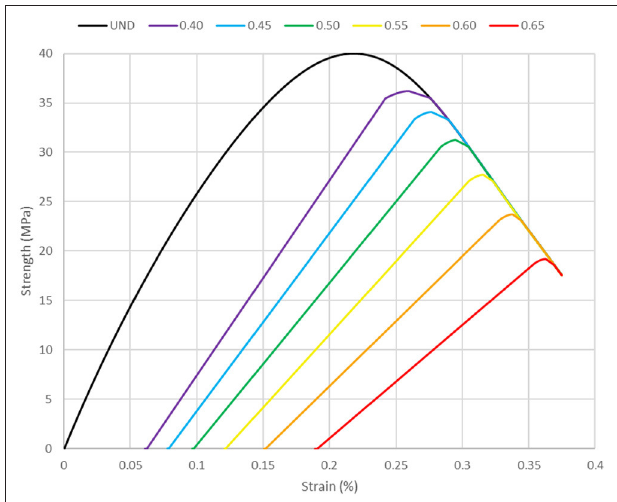
FIGURE 4 | Concrete compressive strength